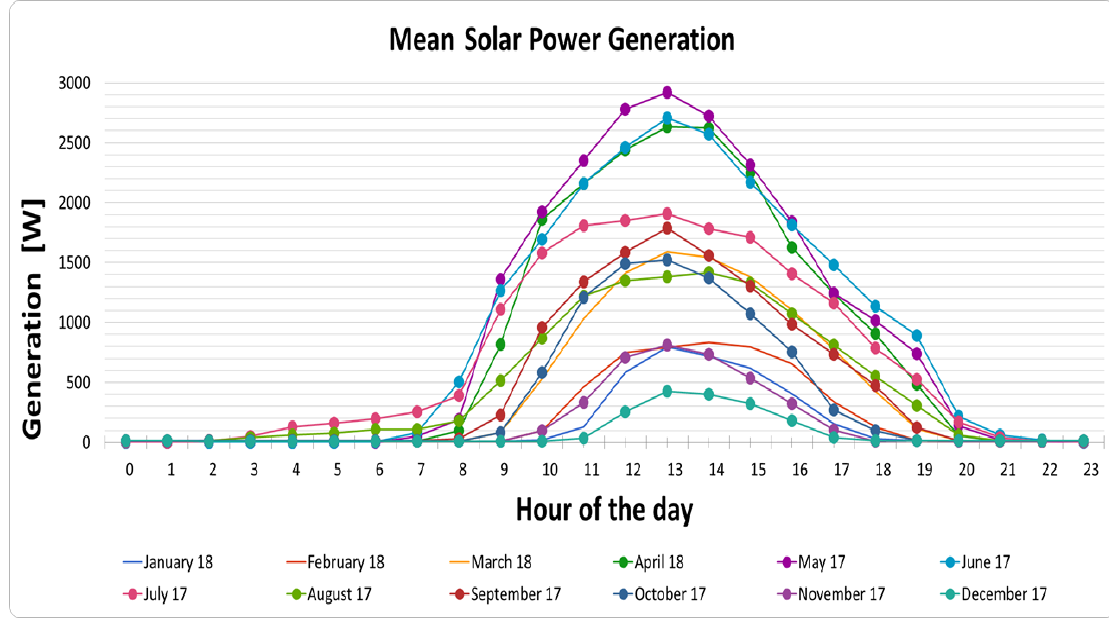
Figure 2. Mean power generation on a monthly basis given in 24 hours per